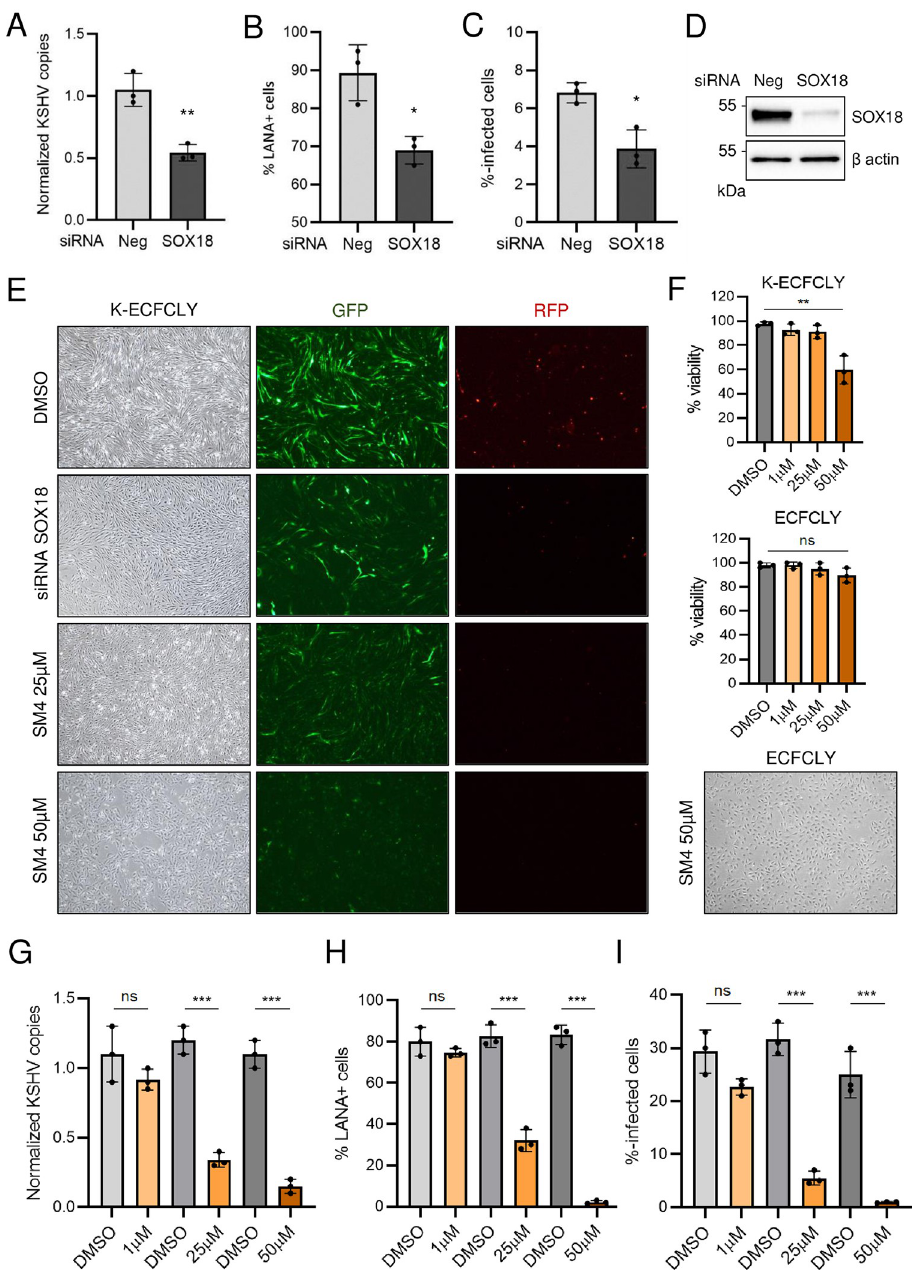
Fig 4. SOX18 inhibition reduces the hallmarks of KSHV infection in lymphatic ECFCs in vitro . Lymphatic ECFCs were infected with KSHV for 5 days, and treated with siRNA targeting SOX18, or control siRNA (siNeg) transfected for 72h (A-E) or with the indicated concentrations of SM4 inhibitor or the corresponding concentrations of DMSO control for 6 days, replenished at day 3 (E-I) . The effect of treatments is shown as quantified; A and G of KSHV genome copies from total DNA, B and H of percent of LANA positive cells on 96-well plate, and C and I of KSHV titers measured from virus release assay on na ï ve U2OS cells. D. The efficiency of SOX18 silencing shown at a protein level. E. Changes in spindling morphology, GFP (latent) and RFP (lytic) cells shown with the siRNA targeting SOX18 or 25 μ M and 50 μ M of SM4 and the highest DMSO concentration control. � p < 0.05, �� p < 0.01, ��� p < 0.001.